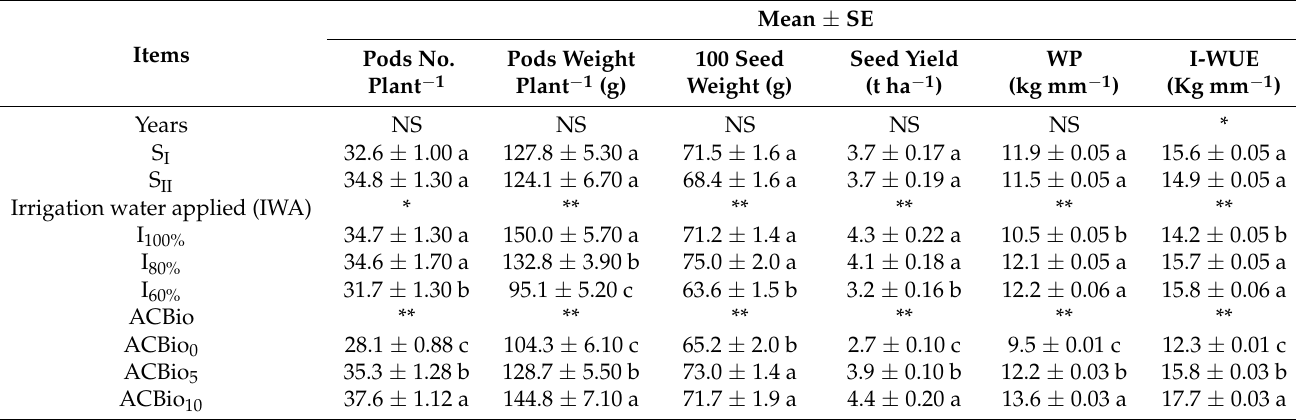
Table 7. Means and standard errors for pod number, pod weight plant − 1 , 100 seed weight, seed yield, water productivity (WP), and irrigation water use efficiency